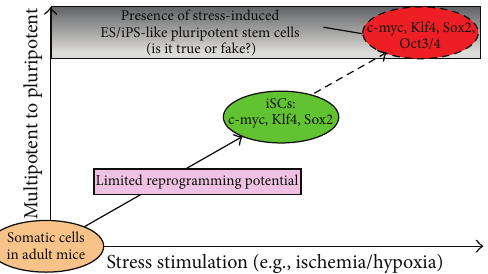
Figure 2: Evidence that iSCs lacking Oct4 have different traits compared with those of ES/iPS cells, suggesting that somatic cells in adult mouse brains have limited reprogramming potential in response to